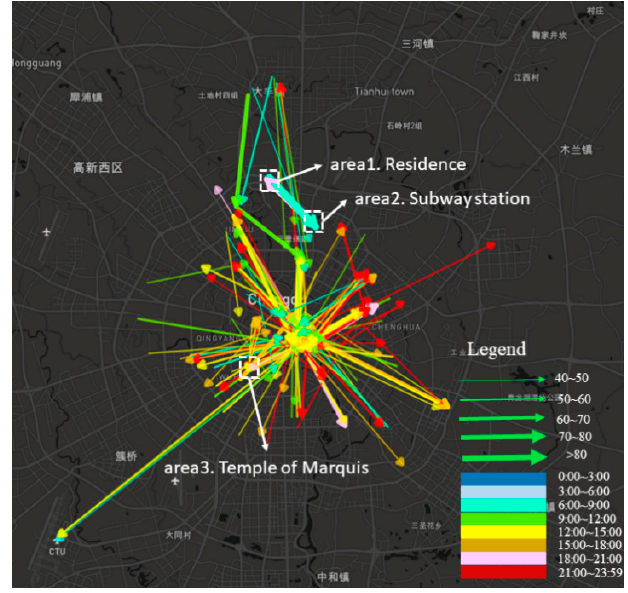
Figure 12. Clustering results for those OD flows whose number is greater than 40.